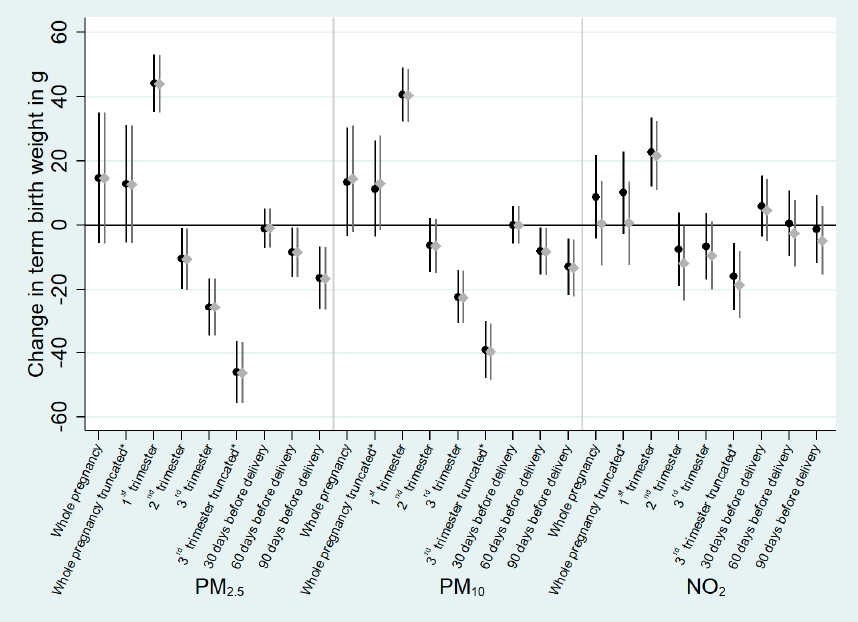
Figure 2. Adjusted difference in mean term birth weight (g) associated with atmospheric pollutant exposures during pregnancy using the doubly robust method ( n = 13,334 pregnant women from ELFE cohort). All effect estimates correspond to an increase of 5 µg/m 3 for PM 2.5 and PM 10 and 10 µg/m 3 for NO 2 . Regression coefficients are from weighted doubly robust generalized additive models 1 . Estimates corresponding to models with full weights (in black) and trimmed weights (in grey) are represented. The point shows the central estimate, the line represents the 95% confidence interval. 1 using the stabilized inverse probability of being exposed to air pollutants calculated using maternal education, in relationship status, parity, sex of the child, maternal active smoking during pregnancy, social deprivation, maternal French citizenship, maternal age, weight before pregnancy and maternal height, and further adjusted for the aforementioned covariates plus urbanization level and season of conception. * exposure truncated at 37 gestational weeks.